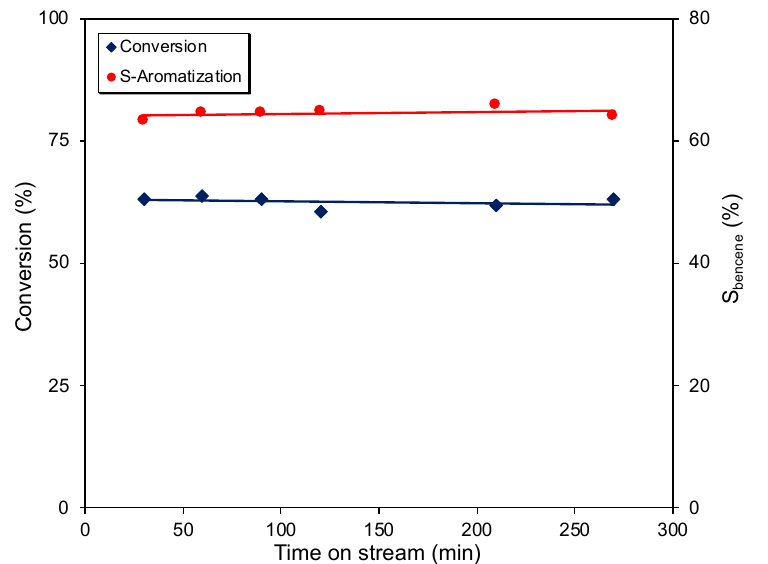
Figure 6. Evolution of conversion and benzene selectivity as a function of time on stream at 475 °C, using C900 5Pt catalysts pretreated at 600 °C.